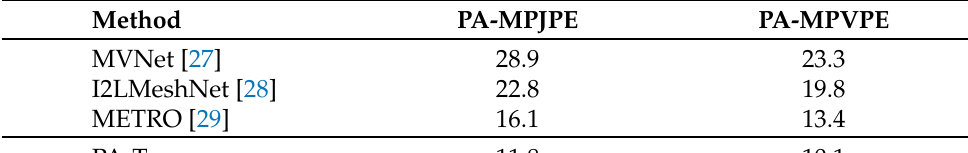
Table 4. Comparisons of the 3D HPE results with SOTA methods on APDM-Hand dataset.